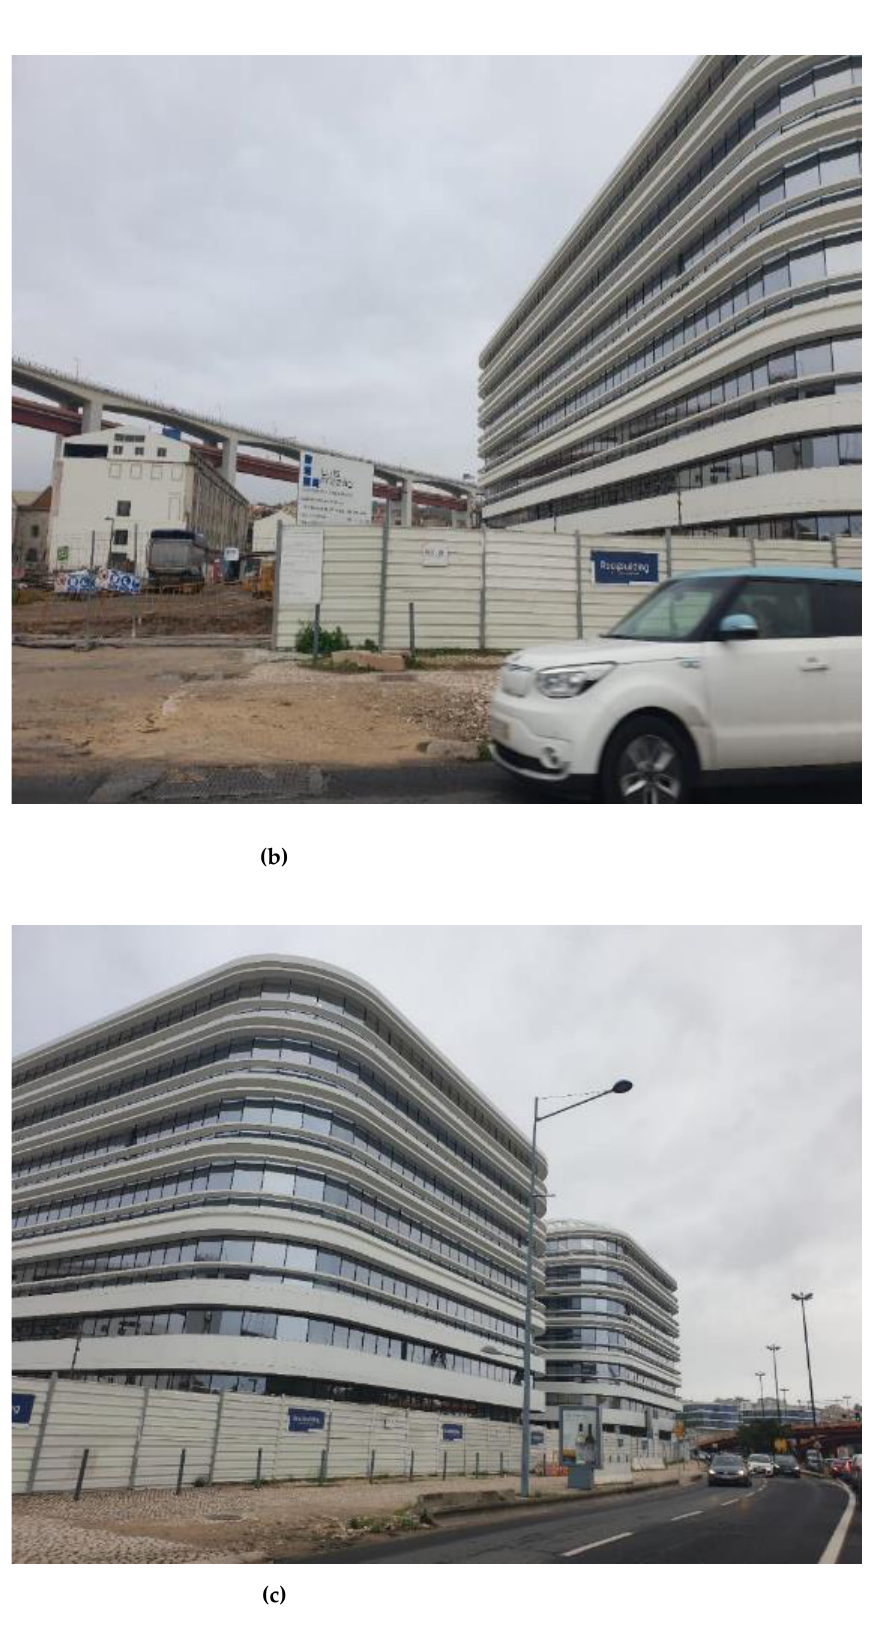
Figure 8. EU Poente—Allo, Source: Sofia Morgado. ( a ) The recently clean plot, seen from Rua da Junqueira, August 2020 ( b ) Work in progress, new office buildings Allo, November 2022 ( c ) Allo and CUF Hospital, the new urban facet towards Avenida 24 de Julho, November 2022.